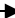
Fig. 3. Frequency spectra of the E intervals. When the emission at (cid:24) 3x F (cid:135) the signal spreads out at high frequency (part a). (cid:68) f (cid:24) 0.1